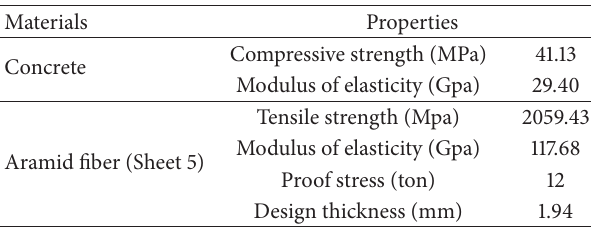
Table 2: Properties of materials.